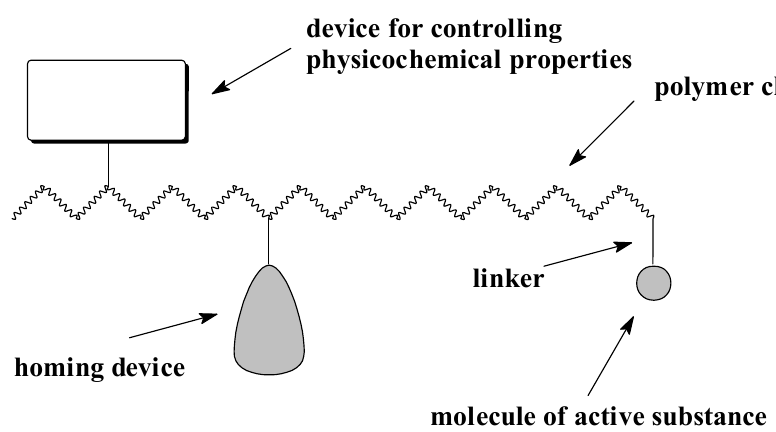
Figure 1. Ringsdorf model of synthetic polymer prodrugs.